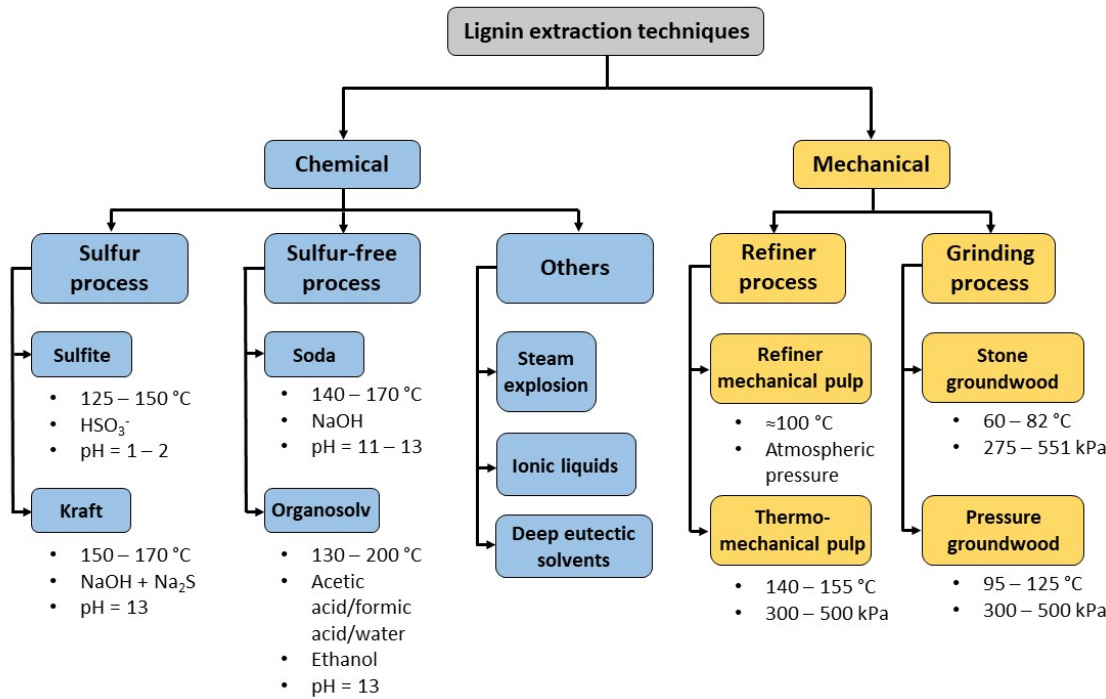
Figure 6. The most common lignin extraction techniques.